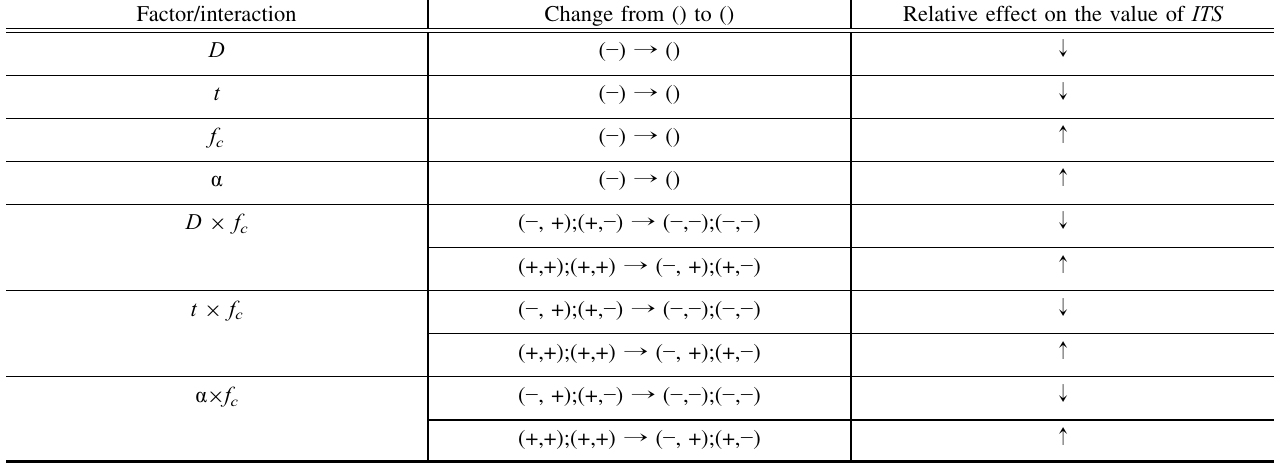
Table 13 A partial summary of the relative effects of the factors and their interactions on the measured Indirect tensile strength (ITS) value with the CUP loading